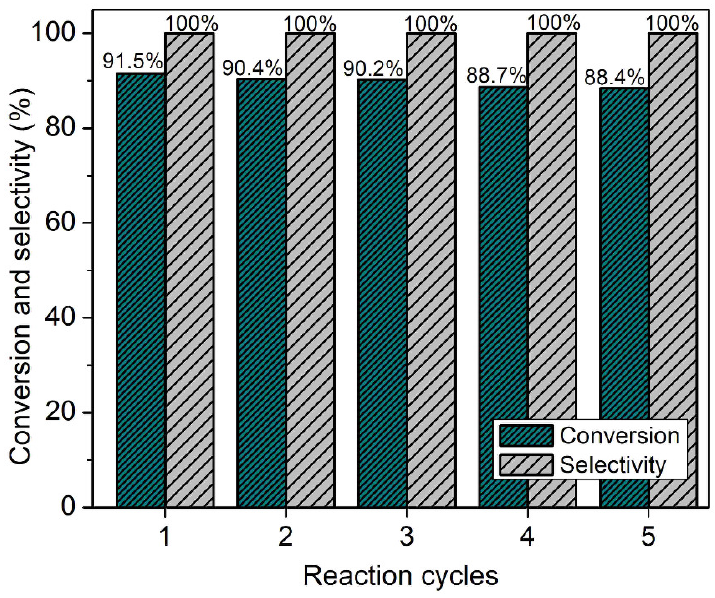
Figure 11. SAPO ‐ 34 catalyst reusability test after five reaction cycles. Figure 11. SAPO-34 catalyst reusability test after five reaction